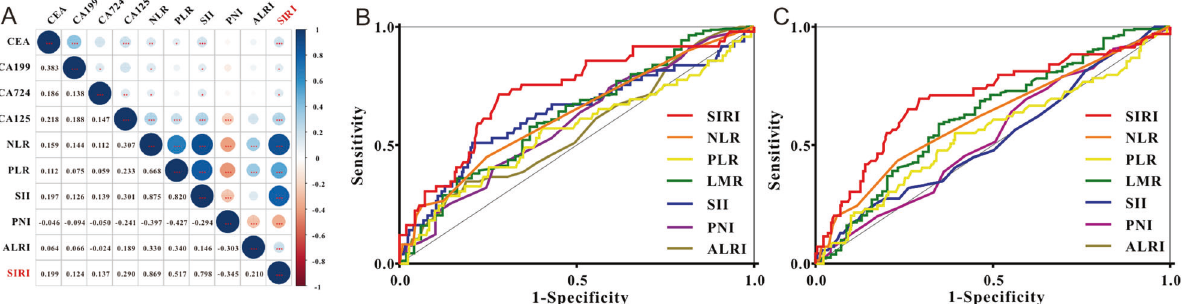
Fig. 1 Clinical correlation and predictive ability of serum in fl ammatory biomarkers. A The relationships between SIRI with other serum in fl ammatory biomarkers and serum tumor biomarkers. B ROC curves of serum in fl ammatory biomarkers for the prediction of overall survival among colorectal cancer patients. C ROC curves of serum in fl ammatory biomarkers for the prediction of disease-free survival in individuals with